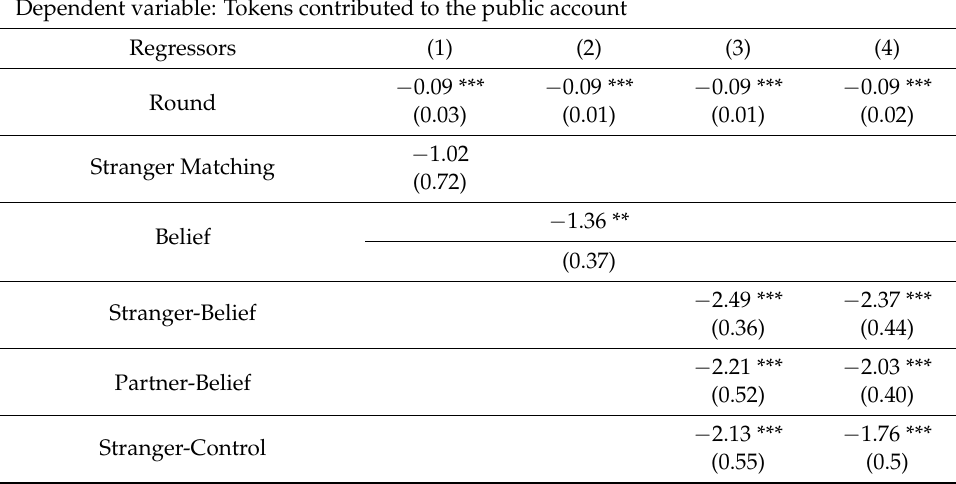
Table A1. Random effects regression with errors clustered on